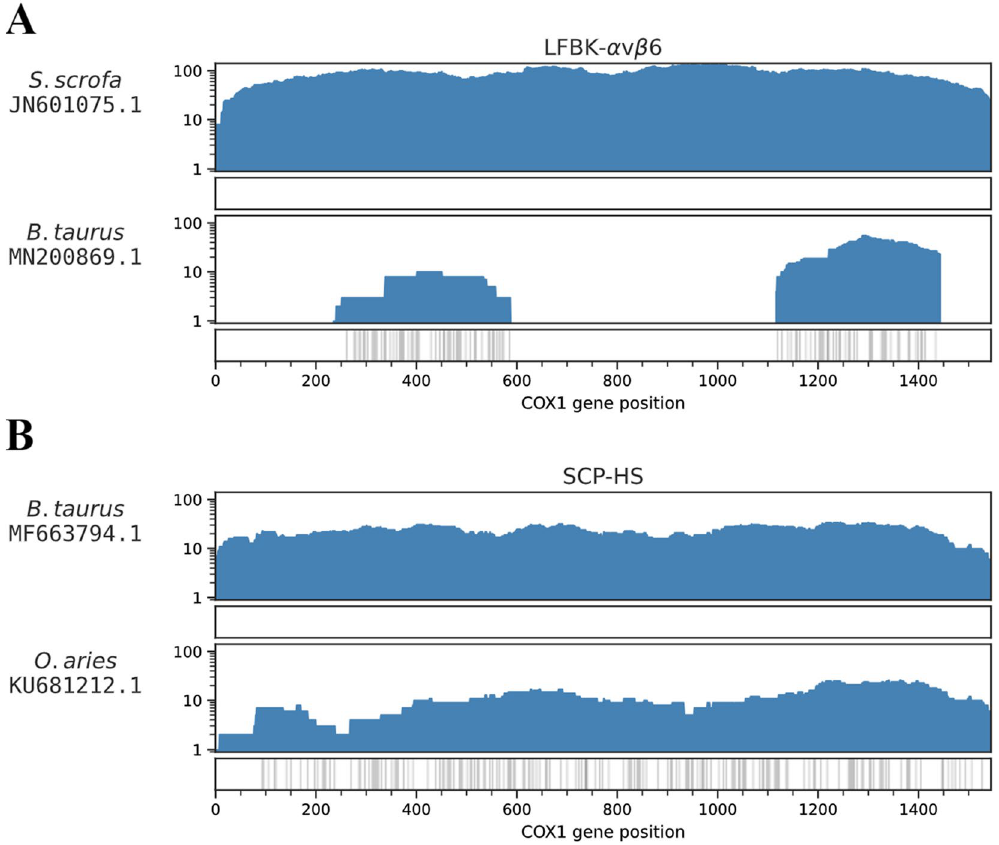
Figure 1. Reference assemblies of LFBK-αvβ6 and SCP-HS reads to references of the expected species and top BLASTn-matched mitogenomes. The nf-illmap workflow was used to map reads from the LFBK-αvβ6 and SCP-HS cell lines to reference COX1 sequences from the expected species of each cell line and the species which showed the top BLAST match to the de novo-assembled sequences. ( A ) LFBK reads were mapped to B. taurus and S. Scrofa . ( B ) SCP-HS was mapped to O. aries and B. taurus . The Y-axis shows the coverage of each genome position. Positions of variants are indicated by the grey lines below the